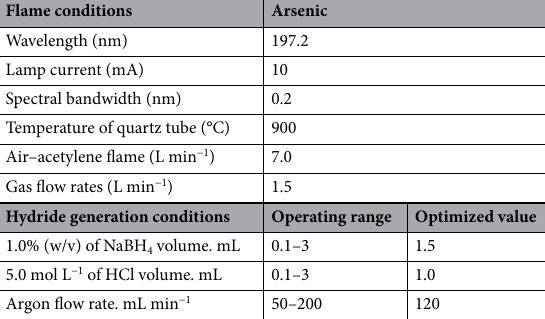
Table 10. Optimal parameters of HG-AAS for the measurement of